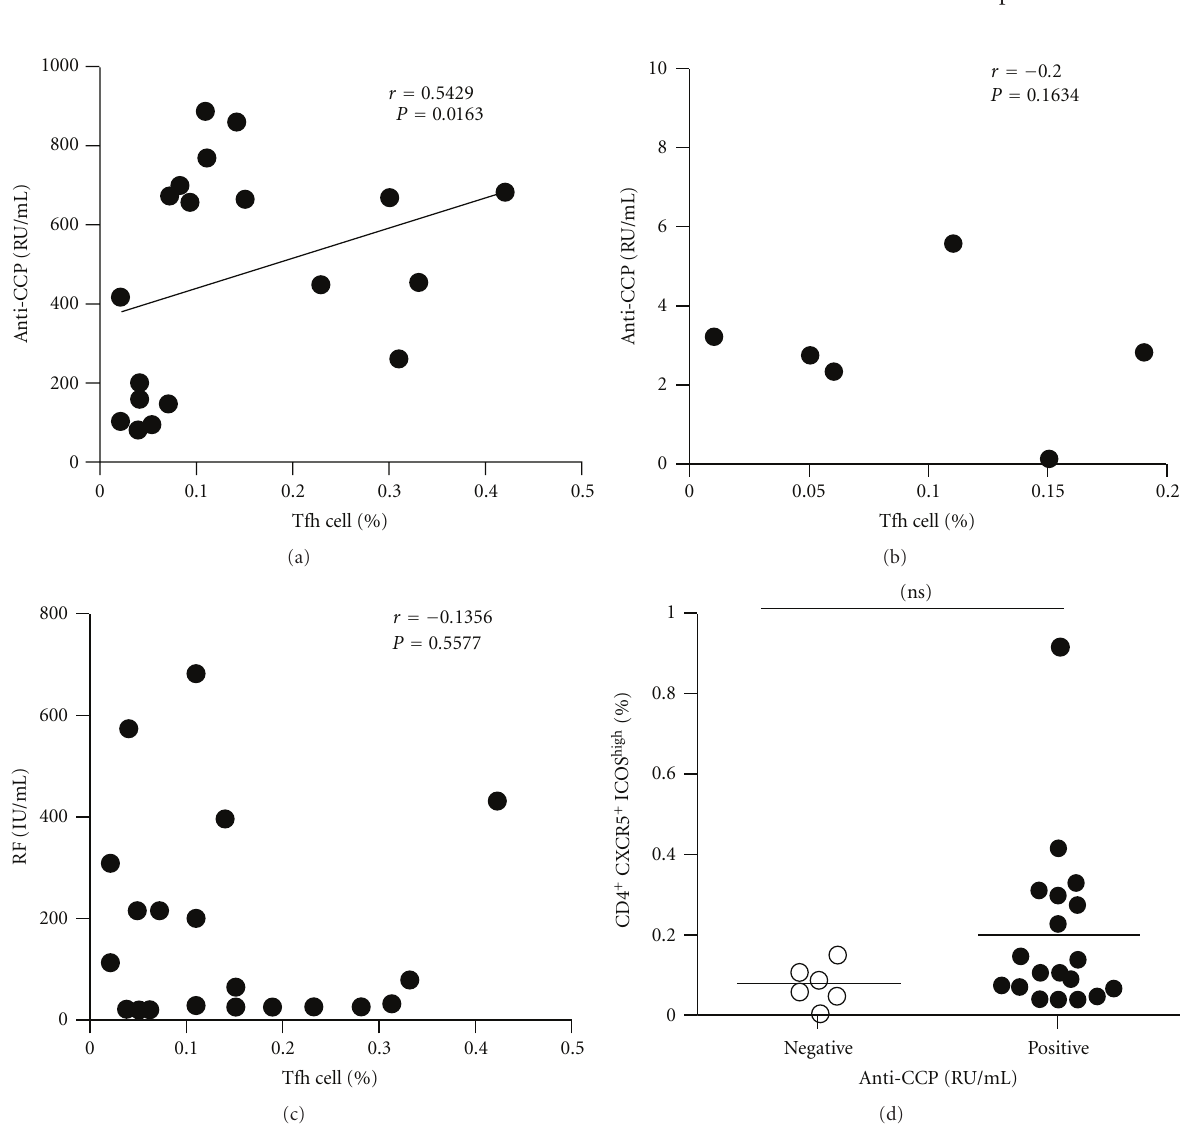
Figure 2: Correlation of circulating Tfh cells frequency and autoantibody in RA patients. (a) Relationship between the frequency of circulating Tfh cells and the positive anti-CCP antibody ( r = 0 . 5429, P = 0 . 0163) ( n = 19). (b) Relationship between the frequency of circulating Tfh cells and the negative anti-CCP antibody ( r = − 0 . 2000, P = 0 . 6134) ( n = 6). (c) Relationship between the frequency of circulating Tfh cells and the level of RF ( r = − 0 . 1356, P = 0 . 5577) ( n = 21). (d) Increased frequency of circulating Tfh cells in RA patients according to anti-CCP antibody. Horizontal lines show the